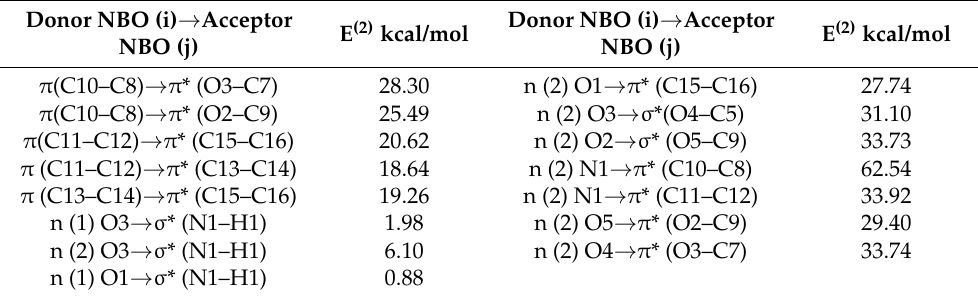
Table 7. The stabilization energy E (2) for HMD.